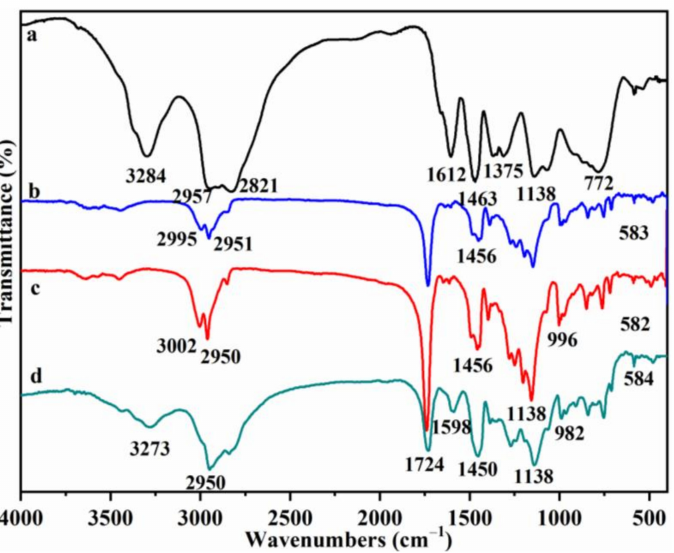
Figure 1. FT-IR of ( a ) PEI, ( b ) magnetic PMMA, ( c ) magnetic PMMA-PGMA and ( d ) PMMA-PGMA-PEI.